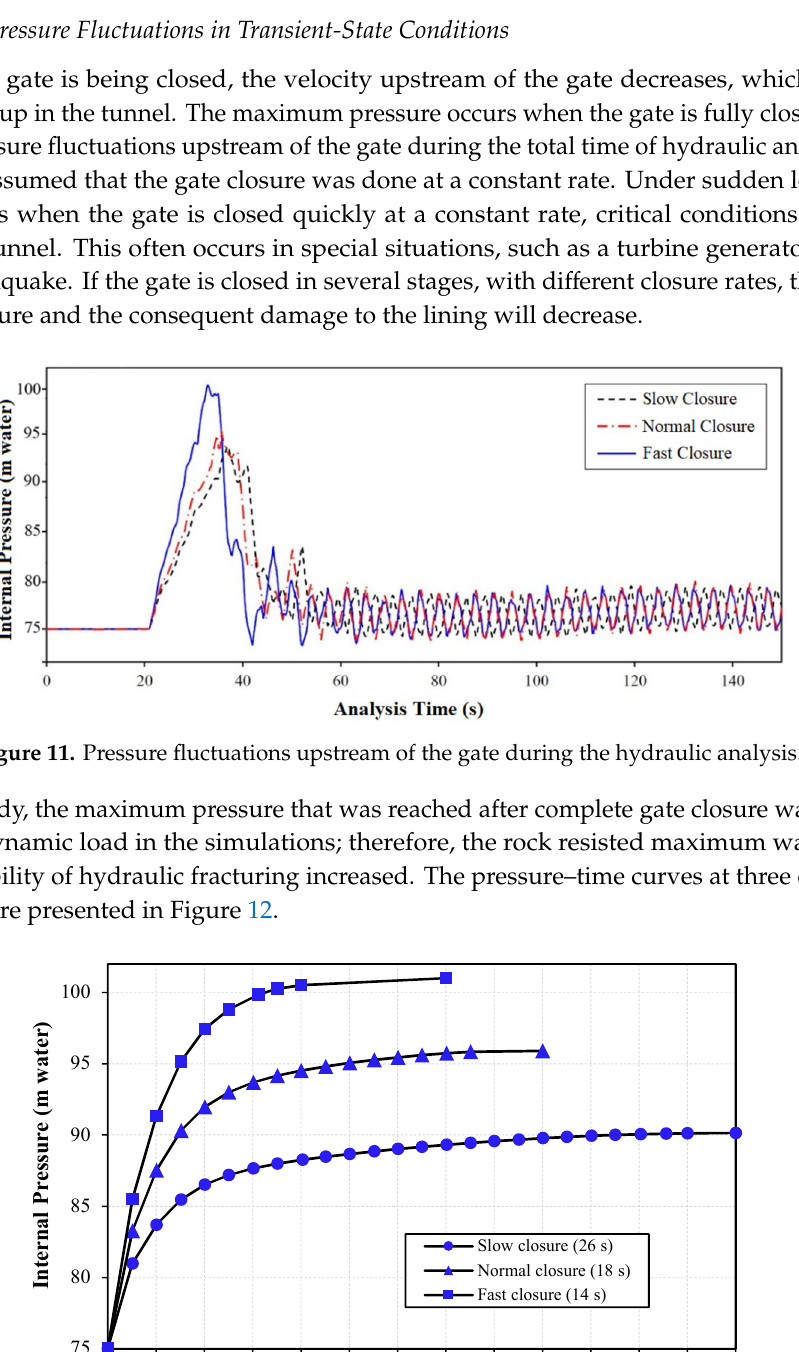
Figure 12. Changes in pressure upstream of the gate, in different scenarios: 14 s, 18 s, and 26 s.